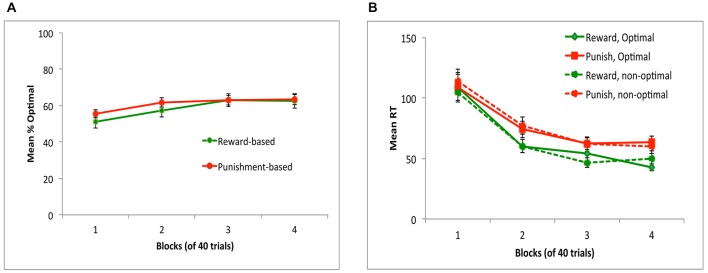
Performance on the task in Experiment 1. (A) Subjects performed equally well on reward-based and punishment-based trials, assessed as percent optimal responding. (B) Mean reaction time (RT) in milliseconds decreased across training blocks, and was slower on punishment-based than reward-based trials. RT did not differ on trials where subjects gave the optimal (correct) vs. non-optimal (incorrect) response.